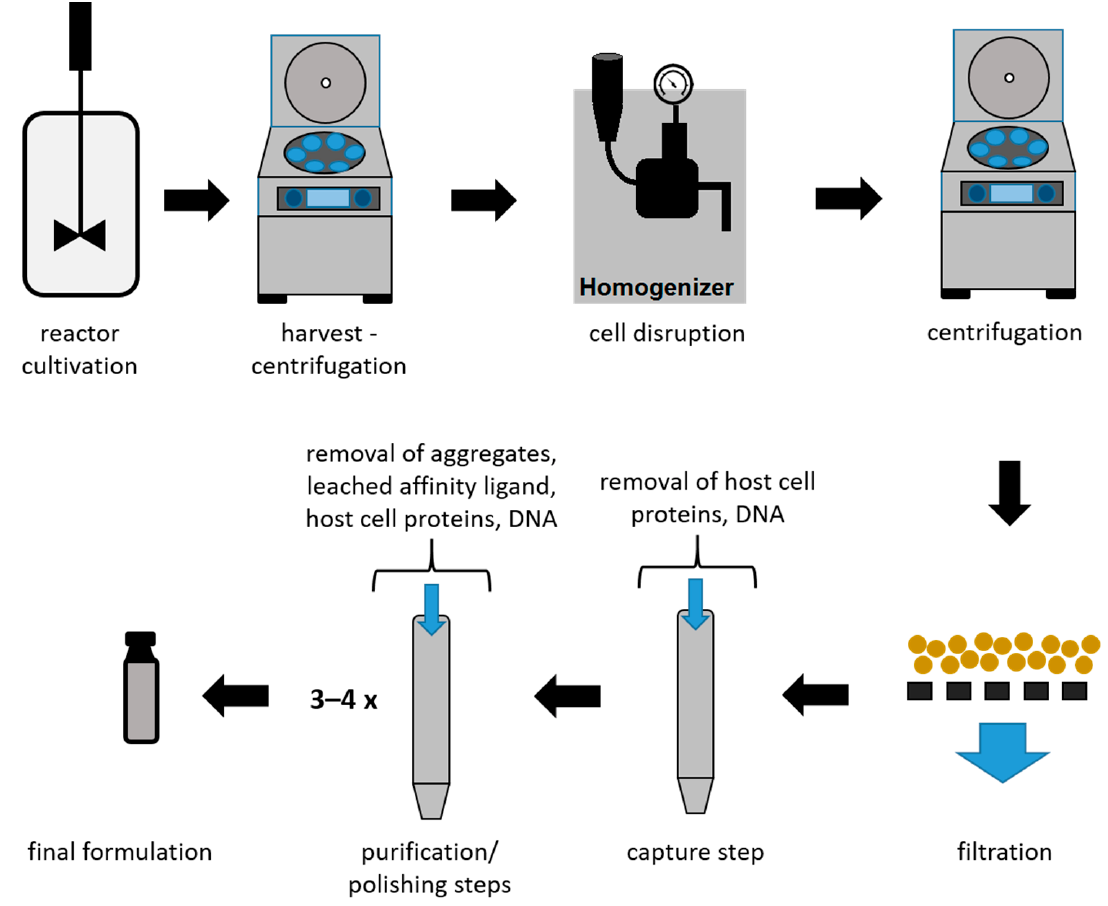
Figure 3. Schematic overview of a bioprocess using E. coli to produce antibody fragments. Table 1. Comparison of chromatographic methods used for the purification of monoclonal antibodies (mAbs) and antibody fragments. AC (affinity chromatography); AEX (anion exchange chromatography); CEX (cation exchange